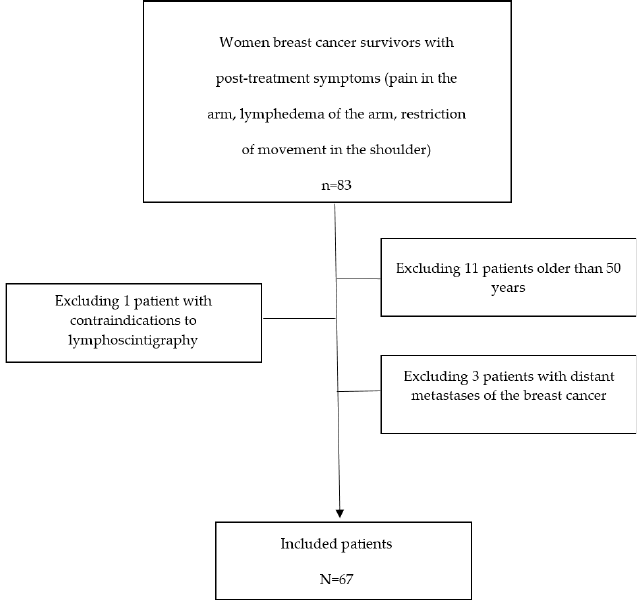
Figure 1. The flowchart of the patient selection process.